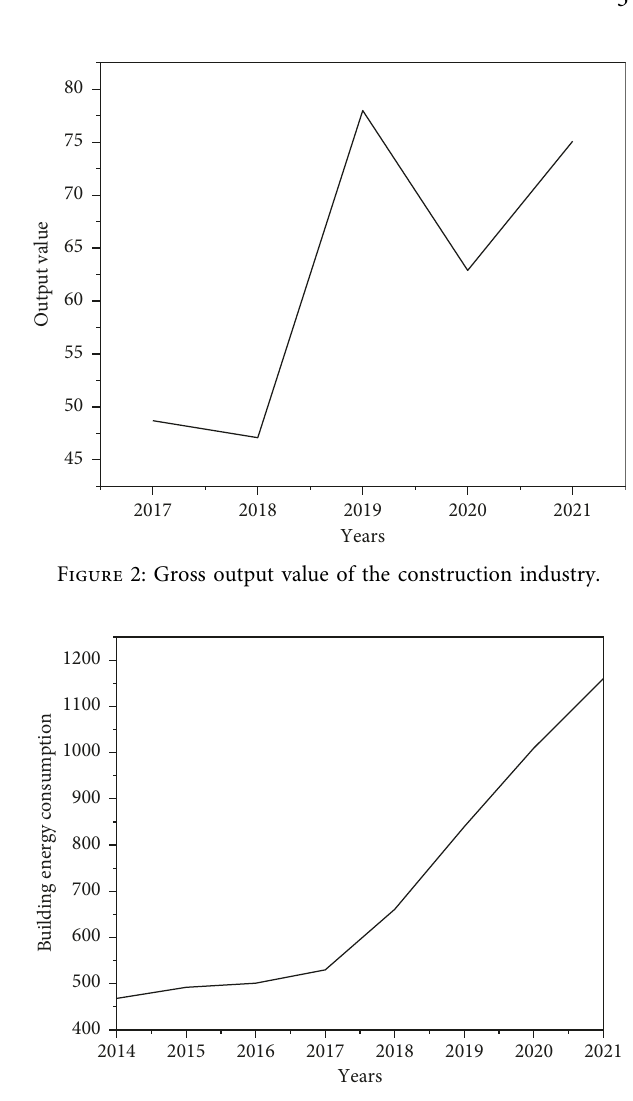
Figure 3: Analysis of building energy